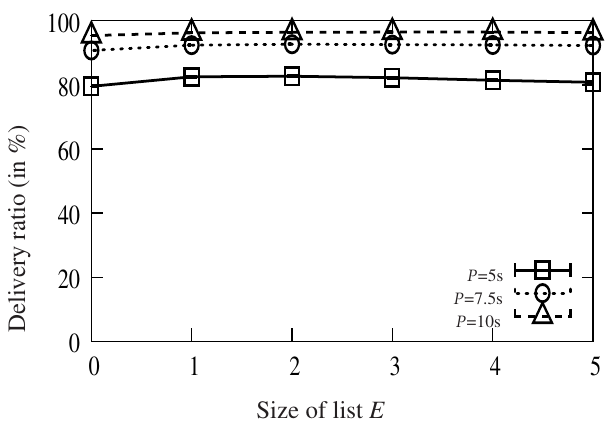
Figure 4. Impact of the size of list E of SLACK-MAC on the packet delivery ratio, with | R | = 2 | E | and a duty-cycle of 1%, where P is the traffic generation period.